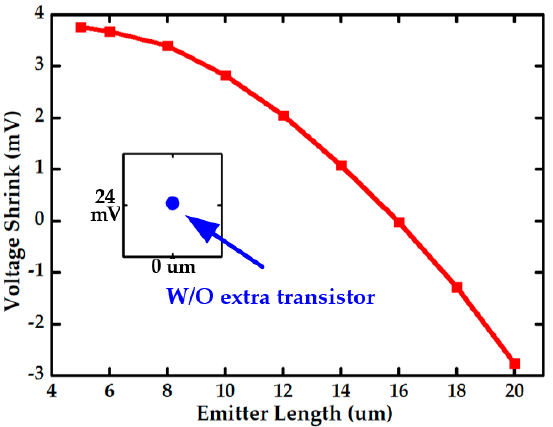
Figure 5. Simulated common-mode voltage fall with different size of Q4 (with 0.15 μ m emitter width).